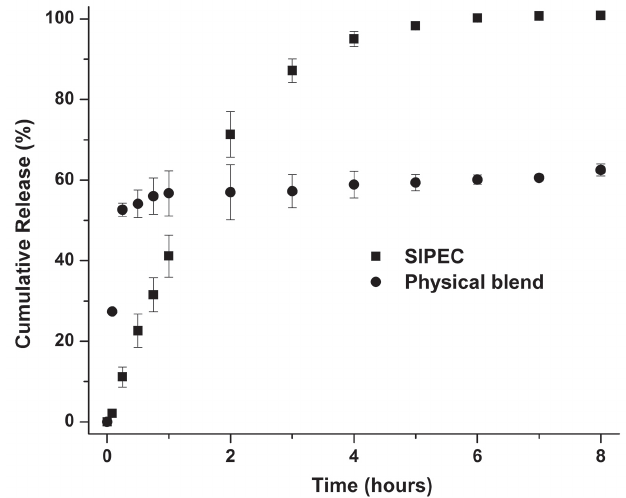
FIGURE 7 - Release profiles of dexibuprofen from a SIPEC and a physical blend of EUE and EUL as matrixes at pH